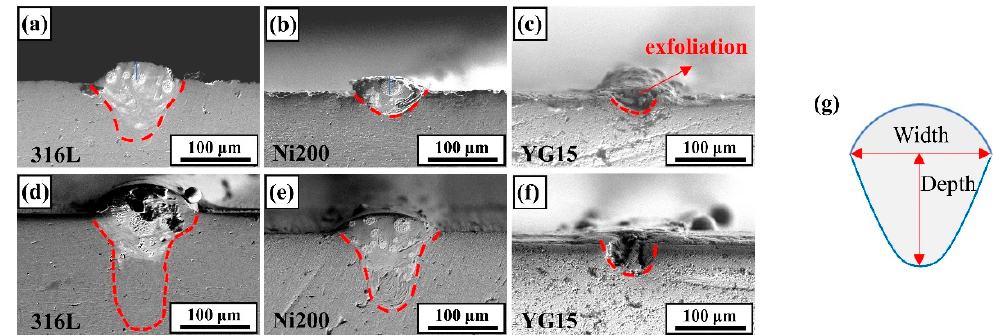
Figure 6. The cross-section of the single tracks: ( a – c ) the single tracks formed at 125 W; ( d – f ) the single tracks formed at 185 W; ( g ) the schematic diagram of the molten pool size.